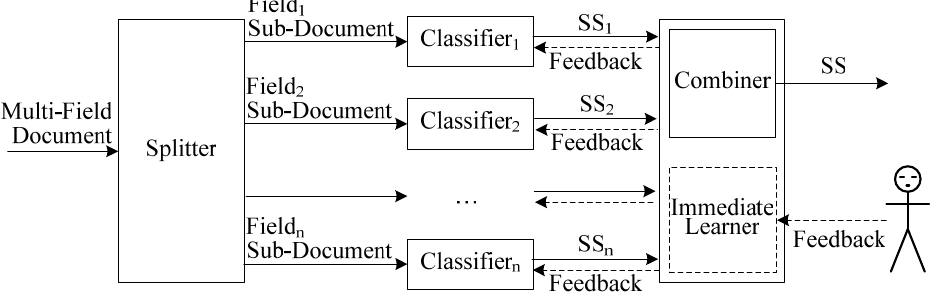
Fig. 2. Multi-Field Learning